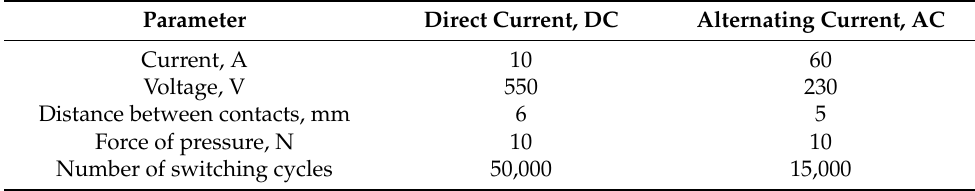
Figure 3. Construction of a single current circuit of the testing device. ( a ) scheme: 1 = fixed contact, 2 = mobile contact, 3 = contact spring, 4 = returnable spring, 5 = mobile contact guiding, 6 = live, 7 = current terminals, 9 = nut adjusting the clamping force, ( b ) the tested contact mounted in a copper holder, ( c ) contact rivets, ( d ) view of the contact of electric rivets [( c ) is reprinted with permission from ref. [27]. Copyright 2016 Polish Academy of Sciences. ( a , d ) are reprinted with permission from ref. [28]. Copyright 2016 Polish Academy of Sciences.) Table 3. Electric and mechanical parameters of the arc erosion resistance tests.